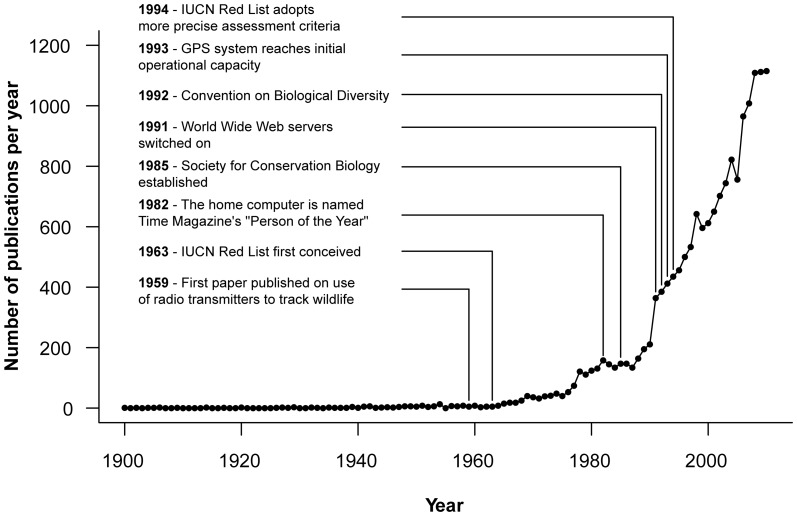
The number of Carnivore papers published per year from 1900–2010.A number of notable dates are also shown.